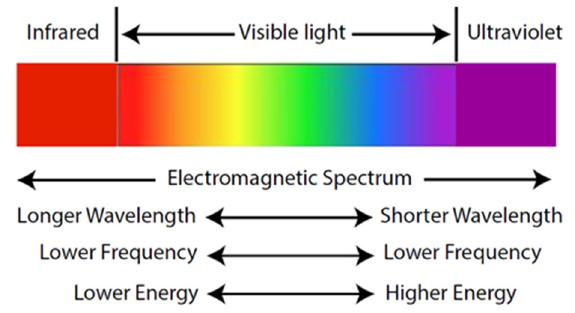
Figure 4. Electromagnetic spectrum of sunlight. Research indicates the surface temperature difference between shaded and unshaded asphalt to be as much as 22 °C [20,21]. Commonly, surfaces with hard or smooth textures indicate a much higher albedo (and thus reflect more UVR) compared to natural ground cover with softer and varied edges, such as grass [15,22]. For this reason, Parisi and Turnbull [15] recommend using natural ground cover as much as possible (or other sur- face materials with low albedos) under shade structures as a substitute for higher-albedo surfaces, such as concrete pavers. Pfautsch et al. [23] examined the importance of shade in preventing playground burns due to overheating of floor surfaces. They found that synthetic turf was one of the hottest surface materials, whereas natural turf was one of the coolest. The authors established that shaded floor surfaces exhibited no meaningful vari- ances in surface temperatures across color tones and materials [23]. According to Madden et al. [11], thoughtfully designed children’s play areas facilitate microscale cooling, thereby delivering much-needed refuge in extreme summer months. Poorly designed play spaces with unsuitable ground surface materials induce micro-heat island effects by raising the air temperature, creating unsafe urban environments for chil- dren’s play. Such hazardous play environments discourage parents from providing out- door play opportunities for their children; in turn, parents promote sedentary activities related to the increased time spent indoors [11]. Skin-damaging UVR remains subliminal to human sensory perception, unlike the heat perceived from infrared radiation (Figure 4) [24]. This inability to perceive UVR can create a false sense of security in users under shade, misleading them into believing them- selves to be safe from UVR exposure and consequently prolonging their stay or dropping their guard. These considerations highlight that effective shading may not be as simple or straightforward as initially supposed. The dimensions of shade structures are another factor that considerably impacts UVR protection. Parisi and Turnbull [15] conducted research with shade structures of diverse sizes and found that the protection factor (PF) offered by the structures decreased as the solar zenith angle (SZA) increased (which results in a lower elevation angle, as seen in Figure 5). Thus, their findings established a direct correlation between the amount of in- direct UVR and the sun’s angle. Furthermore, their research highlighted the importance of accounting for lower sun (elevation) angles when designing structural (built) shade to effectively mitigate direct and indirect UVR. A study by Parsons et al. [25] demonstrates the same. Parisi and Turnbull [15] established that another significant parameter that dic- tates the quality of the built shade is the amount of diffused UVR permeating the shade structures from its exposed sides.